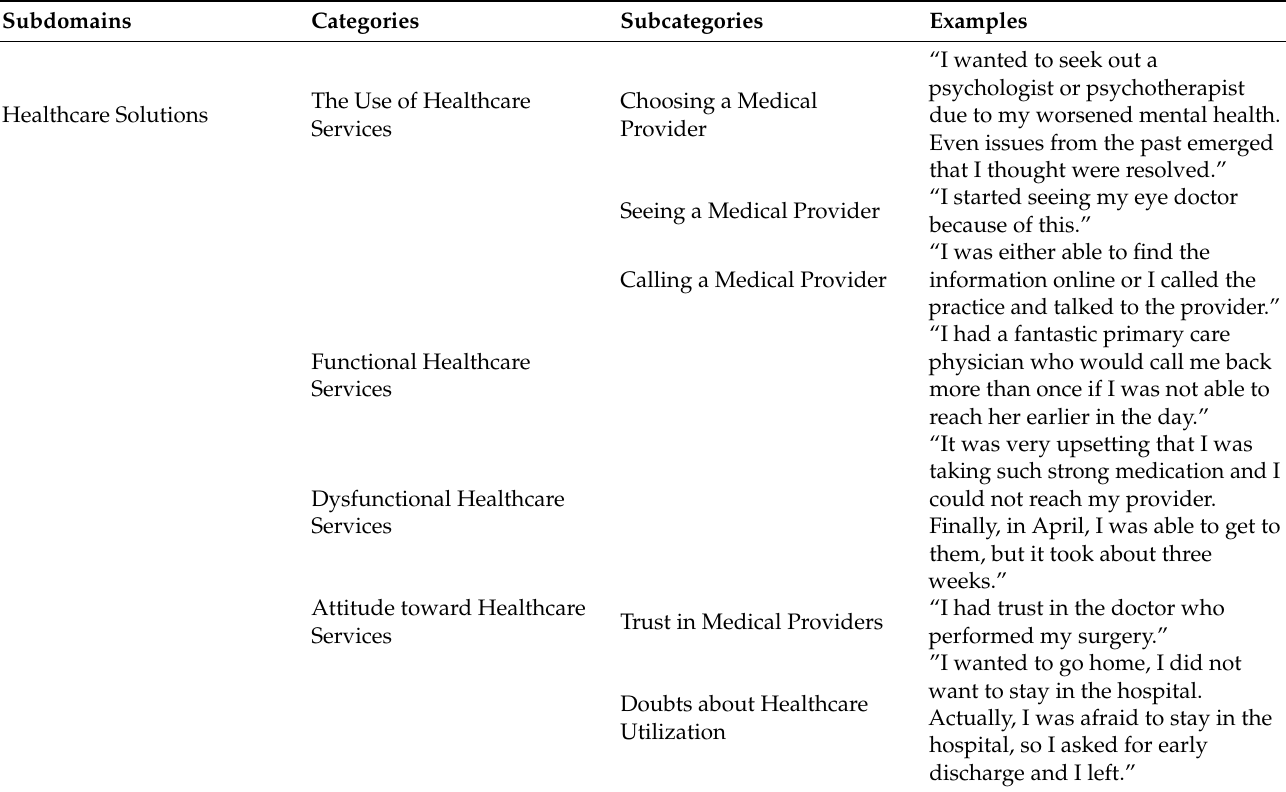
Table 3. Categorization of the domain of dealing with health issues by utilizing healthcare